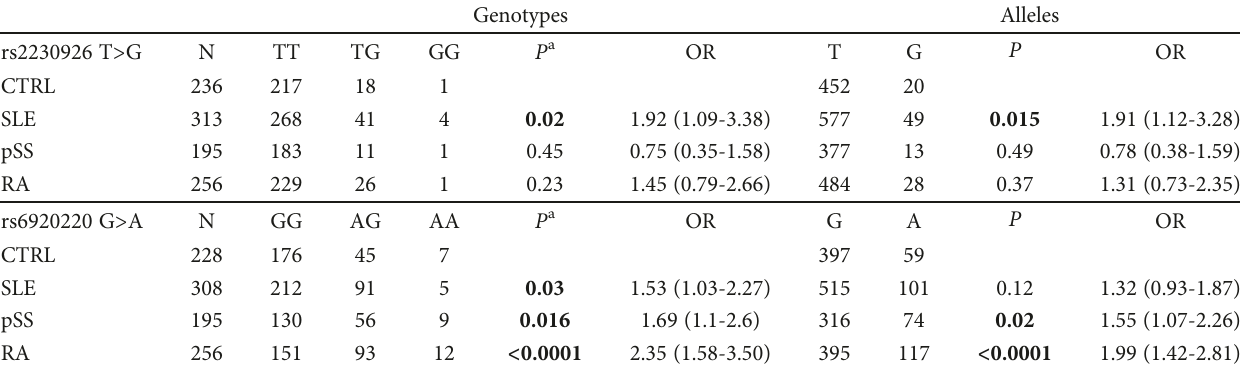
Table 1: Distribution of genotypes and alleles of the investigated TNFAIP3 polymorphisms in SLE, pSS, RA, and healthy controls. Genotypes Alleles